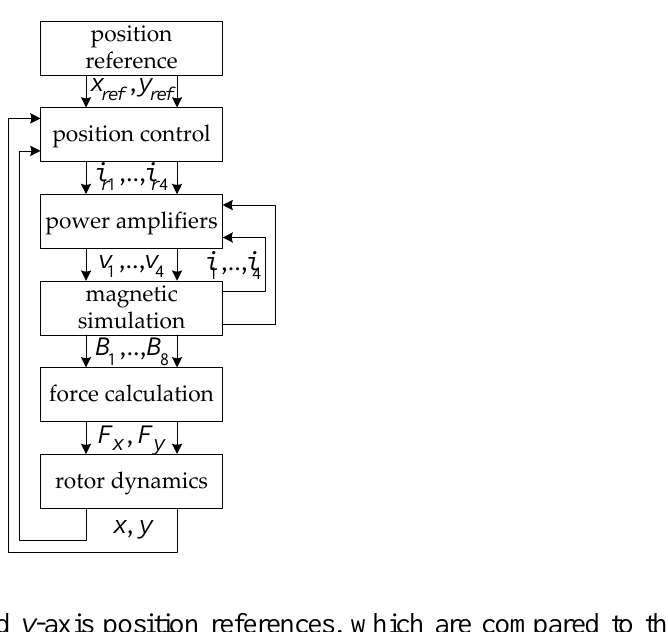
Figure 6. Flow diagram of the transient simulation